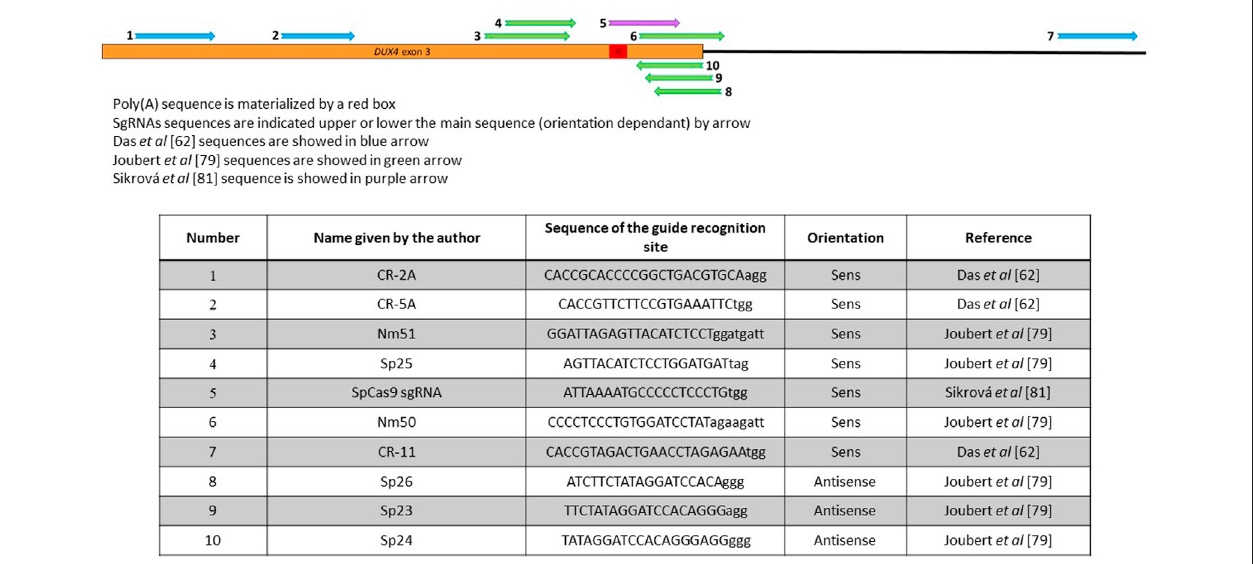
FIGURE4| PositionofthedifferentsgRNAsusedthattargetthe3 ′ UTRofDUX4.TheDUX4poly(A)sequenceismaterialized byaredbox.SgRNAssequencesare indicatedupperorlowerthemainsequence(orientationdependant)byarrow.SequencesinDas2021,Joubert2020orSikrová2021areindicatedinblue,green,purple respectively. Sequences are indicated in the lower part of the fi